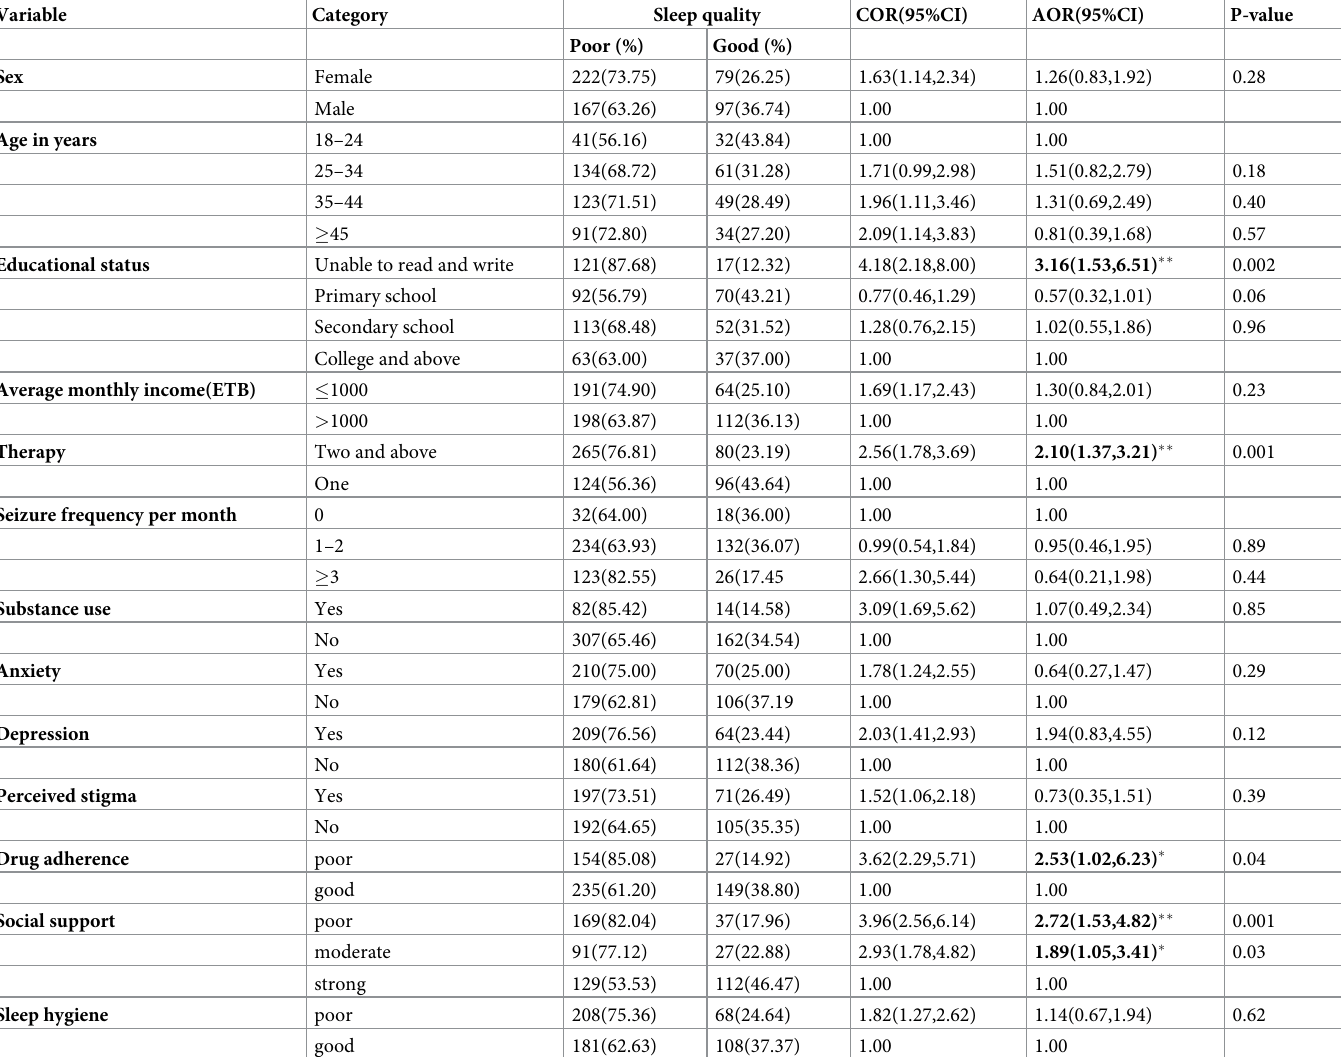
Table 5. Factors associated with poor sleep quality among adult epileptic patients attending follow-up care at referral hospitals in Amhara region, Ethiopia,